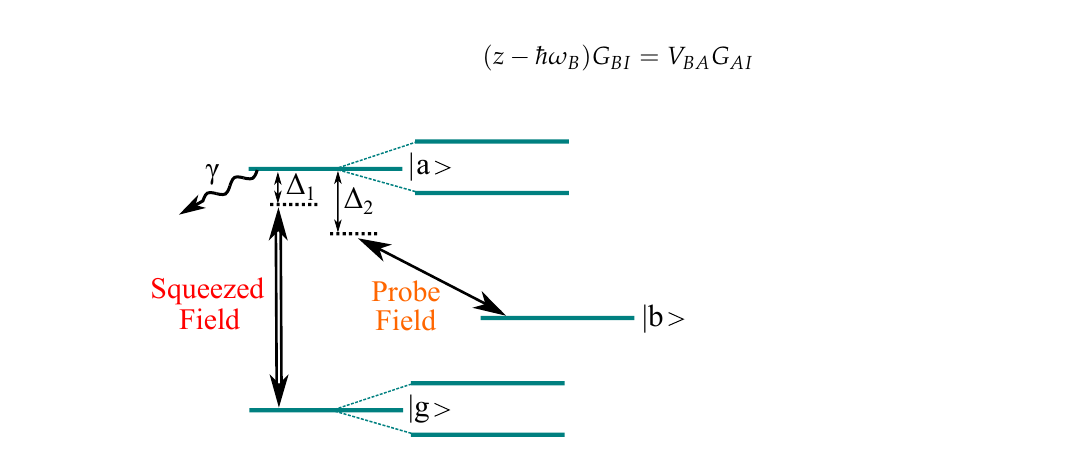
Figure 1. Schematic presentation of the system of study. A strong radiation field prepared initially in a squeezed coherent state drives the | g (cid:105) ↔ | a (cid:105) transition, resulting in a Stark splitting of both states. This splitting is monitored through the calculation of the population of state | b (cid:105) as a function of ∆ 2 , which is assumed to be weakly coupled to state | a (cid:105) through a probe